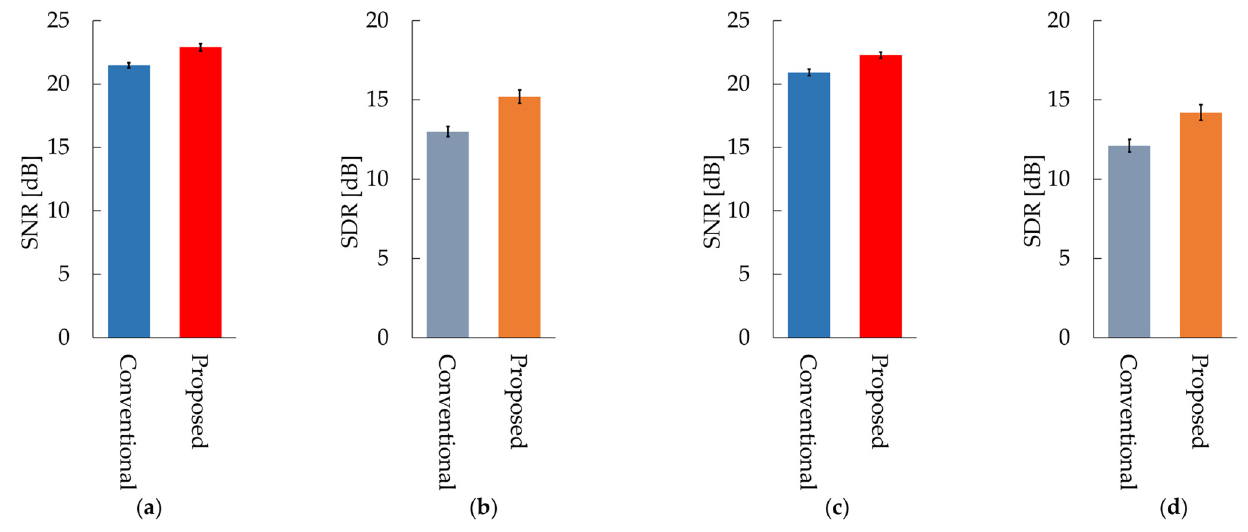
Figure 8. Results of the conventional method SCNMF and proposed method OCNMF: ( a ) signal-to-noise ratio (SNR) in 800 Hz sine wave noise; ( b ) signal-to-distortion ratio (SDR) in 800 Hz sine wave noise; ( c ) SNR in male voice noise; ( d ) SDR in male voice noise.